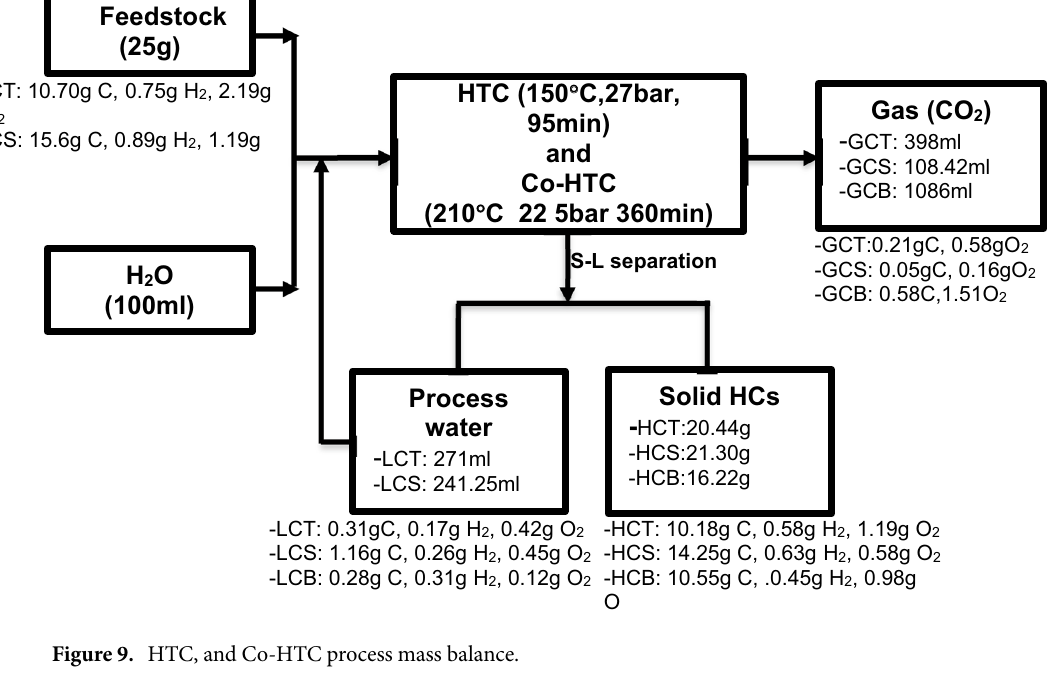
Figure 9. HTC, and Co-HTC process mass